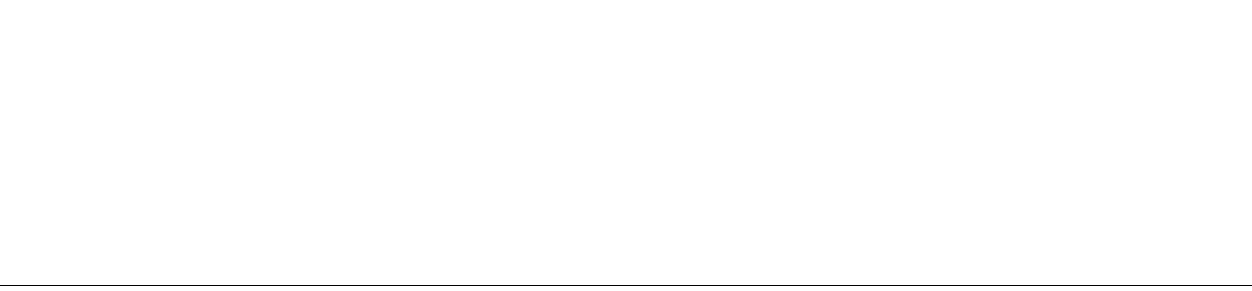
FIGUREA2 | (A) The total amount of information available from each component after taking a weighted sum by the CSF at a given distance.The y -axis is normalized to put the maximum information at